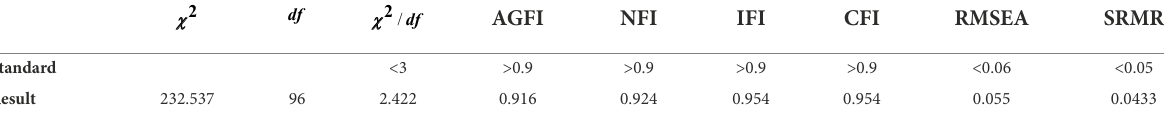
FIGURE 2 Path coefficient test.